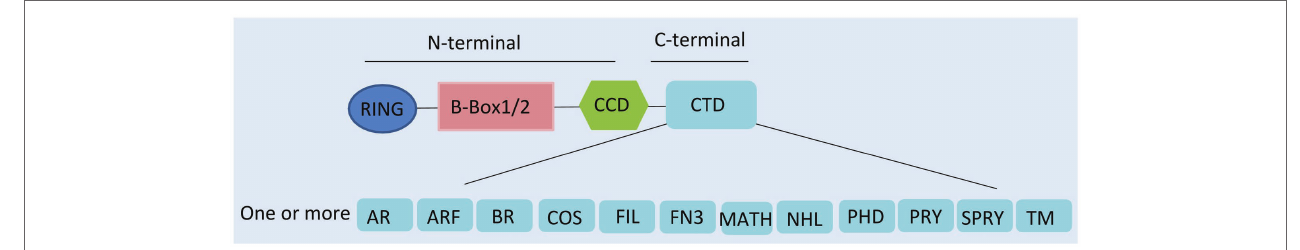
FIGURE 1 | Domain structure of tripartite motif-containing protein (TRIM) family proteins. TRIM contains a RING domain, a B-box 1 and/or B-box 2 domain, a coiled-coil domain (CCD), and distinct C-terminal domains. AR, acid-rich region; ARF, ADP ribosylation-like factor; BR, bromodomain; COS, C-terminal subgroup one signature; FIL, filamin-type immunoglobulin; FN3, fibronectin type 3; MATH, meprin and tumor-necrosis receptor-associated factor homology; NHL, NHL repeats; PHD, plant homeodomain; PRY, SPRY-associated domain; SPRY, SPIa, and the ryanodine receptor domain; and TM,